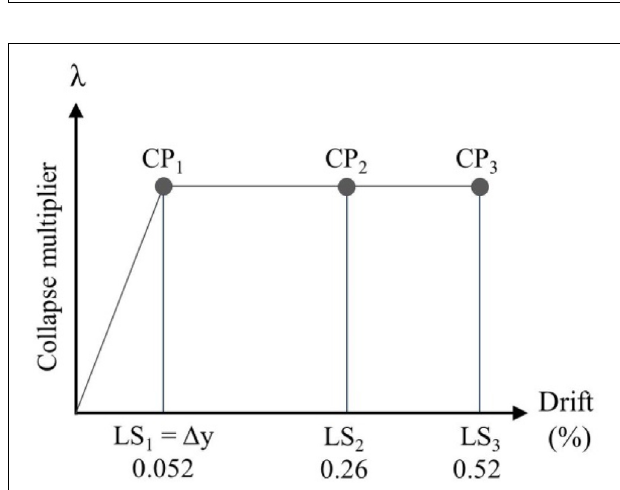
FIGURE 2 | Bilinear capacity curve for adobe buildings and corresponding control